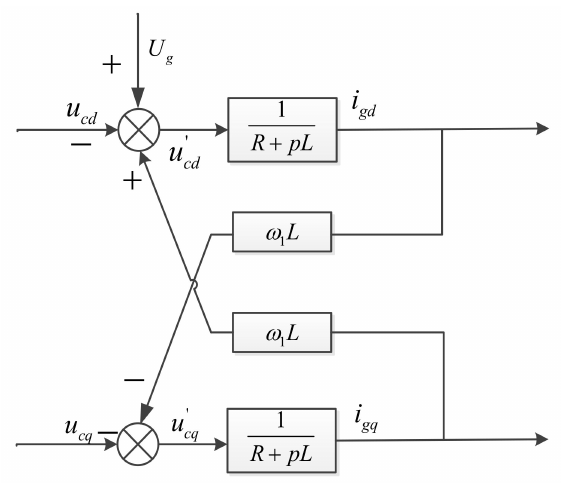
Figure 4. The dq current inner loop control of